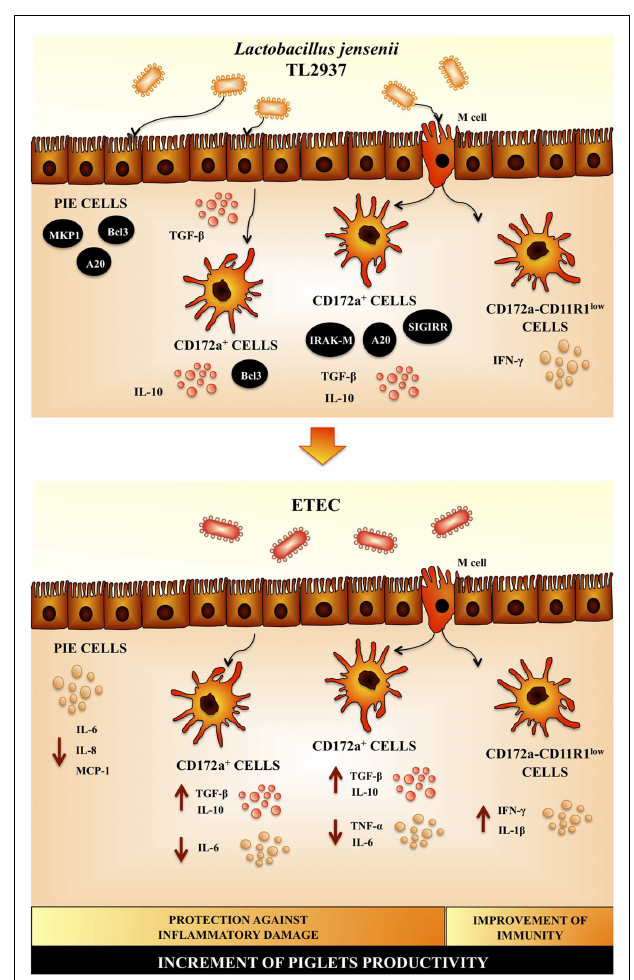
FIGURE 3 | Proposed mechanism for the immunoregulatory effect of Lactobacillus jensenii TL2937 in porcine intestinal mucosa .